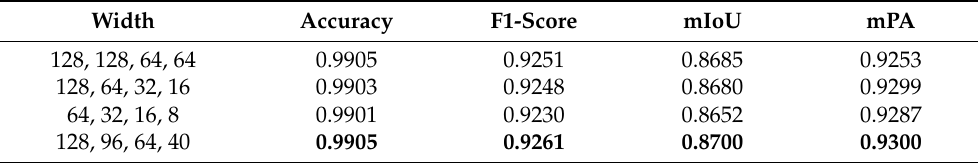
Table 6. Results of different